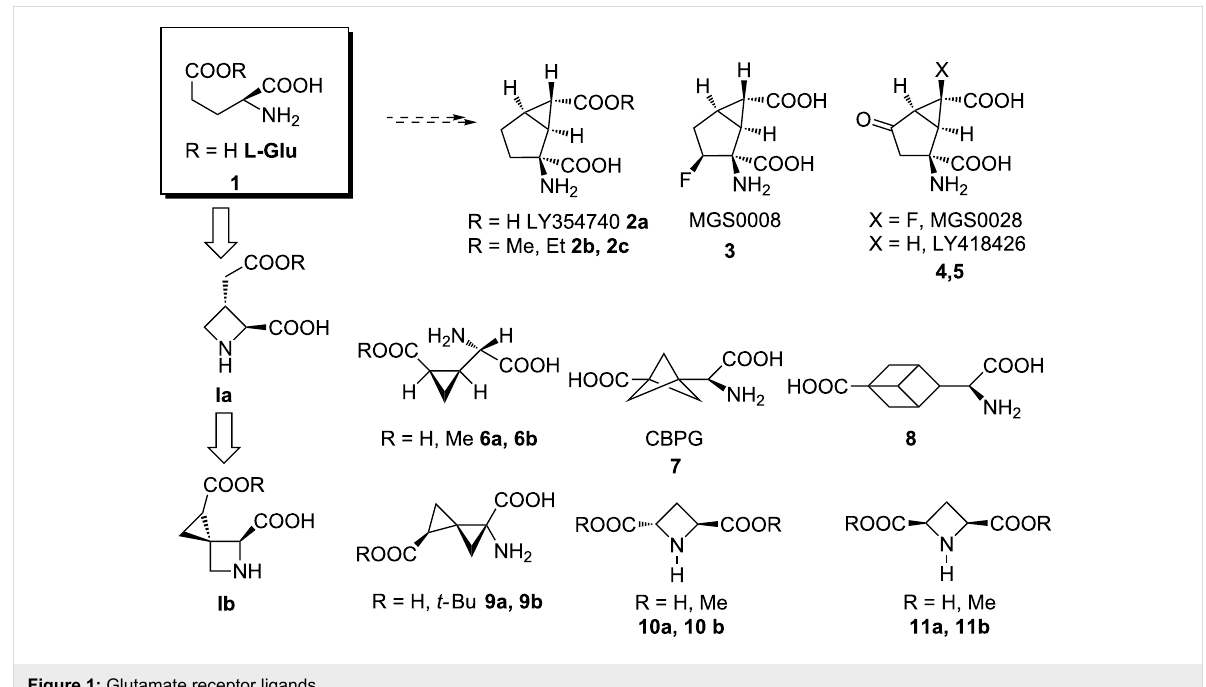
Figure 1: Glutamate receptor